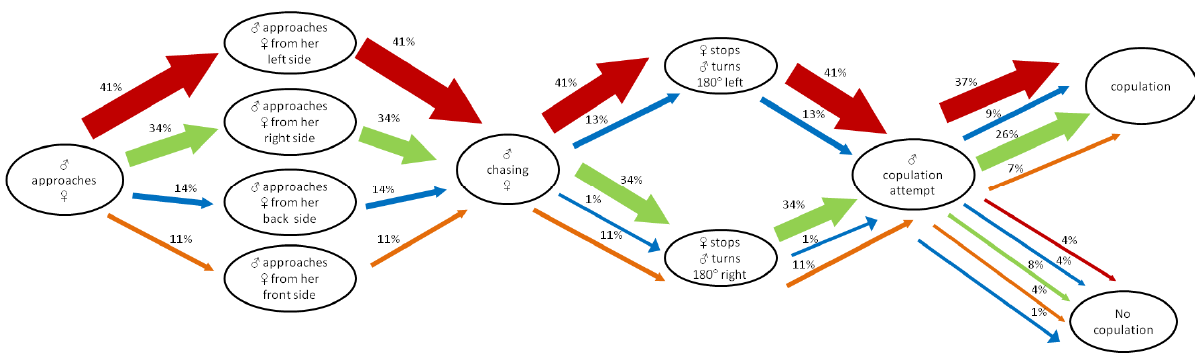
Figure 1. Flow chart showing population-level behavioral asymmetries during courtship and mating of Cryptolestes ferrugineus . Red, green, blue and orange arrows indicate the body side of females (left, right, back and front, respectively) approached by males. Red and green arrows also indicate the lateral turn of males before the genital contact. The thickness of each arrow indicates the proportion of beetles displaying each behavior ( n = 139 mating pairs).